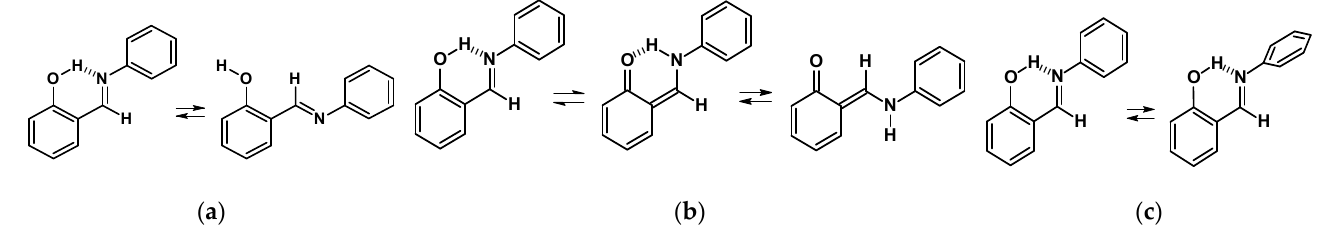
Figure 1. Conformational equilibria of 2-[(E)-(phenylimino)methyl]phenol.